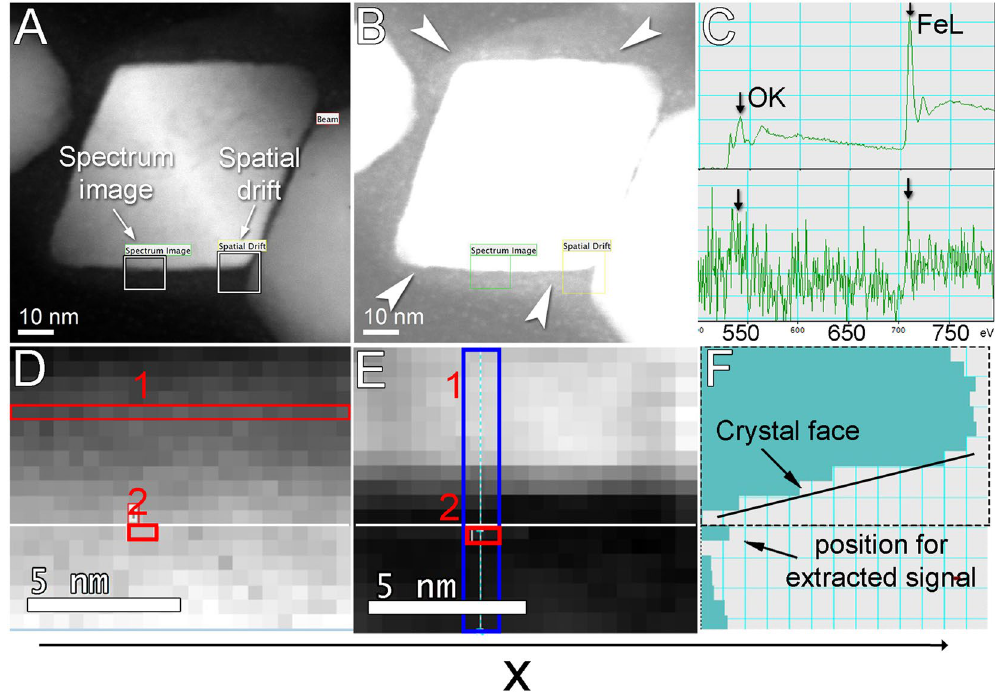
Figure 6. Electron energy loss spectroscopy (EELS) of an isolated Fe 3 O 4 magnetosome from Magnetofaba australis strain IT-1 analyzed with spectral imaging at high spatial resolution (dwell time 2 s, beam intensity 0.038 nA camera length 2 cm, pixel size 0.5 nm). ( A ) STEM image of a magnetosome Fe 3 O 4 crystal showing areas used for the analysis and drift correction (white rectangles). ( B ) Contrast stretching of the same image shown in ( A ) highlighting the surrounding membrane (white arrows). ( C ) EELS spectra obtained by the addition of spectra contained in each pixel of the same scanning line in ( D ); top: Spectrum corresponding to horizontally elongated rectangle (line 1) showing characteristic edges (arrows) for O (540 eV) and Fe (710 eV); bottom: Spectrum corresponding to line 2 obtained by the addition of 2 pixels along the line showing characteristic edges (arrows) for O (540 eV) and Fe (710 eV). ( D ) Spectrum obtained from the region shown in the square box in ( A ). Each pixel corresponds to one spectrum (pixel size 0.5 nm × 0.5 nm). ( E ) STEM-HAADF thickness map or profile map of the square region shown in ( A ). The intensity of each pixel is proportional of the sample thickness. ( F ) Projection profile of the addition of two pixels along the X axis of the HAADF intensity contained in the blue rectangle in ( E ). From bottom of ( C, D, E and F ), we assume that: (1) position 2 is outside the crystal ( D,E and F ), (2) in position 2 there is Fe (bottom of C ) and thus Fe (other than Fe 3 O 4 ) is inside the magnetosome membrane vesicle.